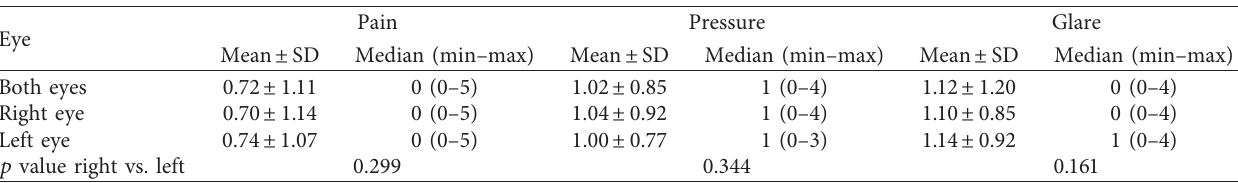
Table 2: Perception of pain, pressure, and glare in the control subgroup (without change of any parameter between the right and left eye): mean ± SD, median (min-max); p values of Wilcoxon signed-rank test between right and left